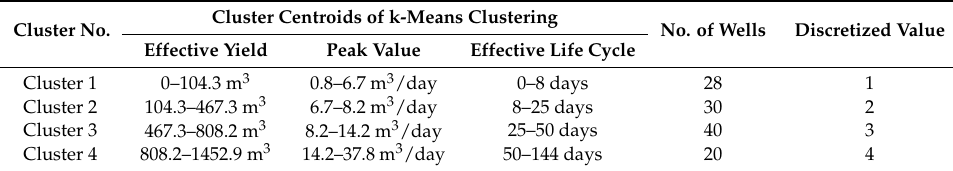
Table 1. Discretization results of the oil production performance parameters. Cluster No.